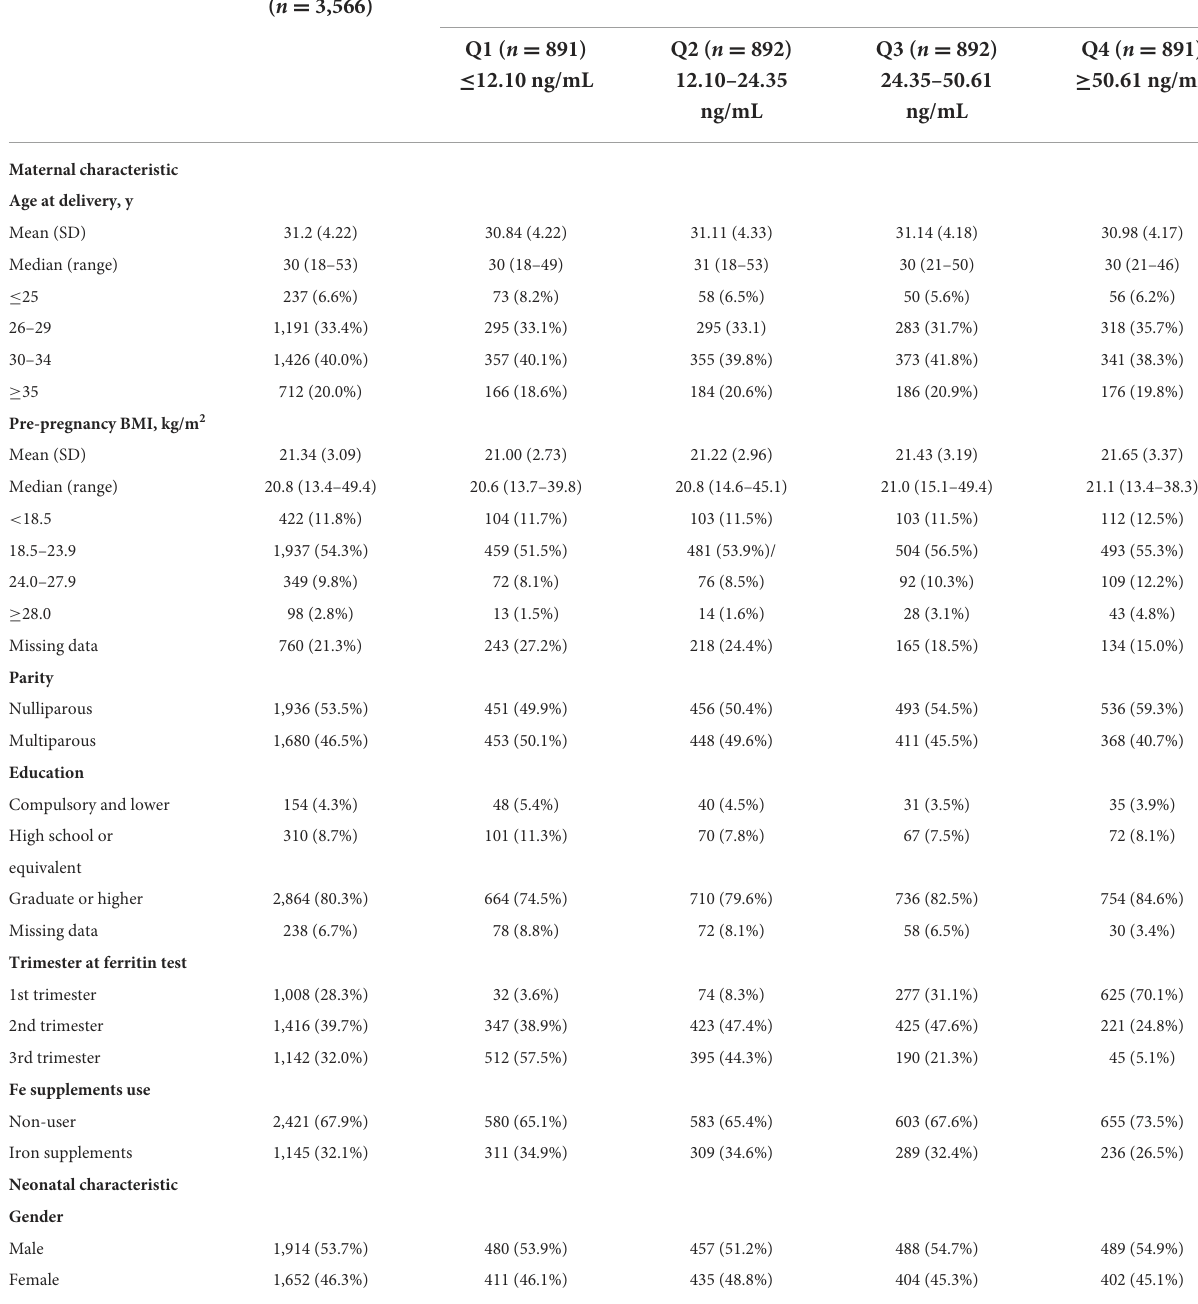
TABLE 1 Basic characteristics according to quartiles of maternal ferritin